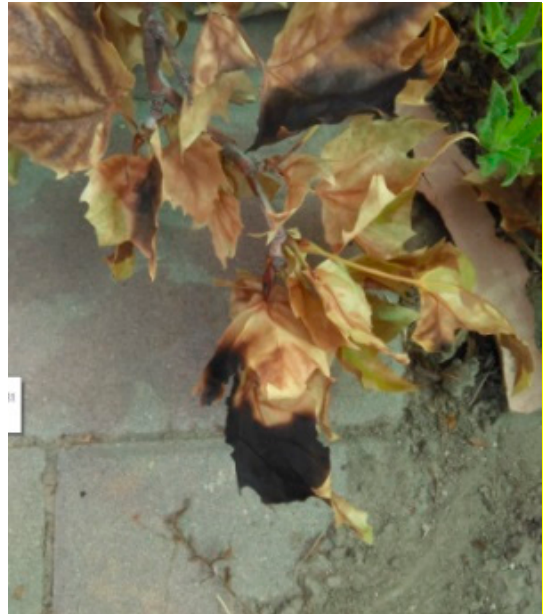
Figure 18. Unwanted effect of end losses; tree leaf burned by the concentrated solar energy from the receiver prototype.